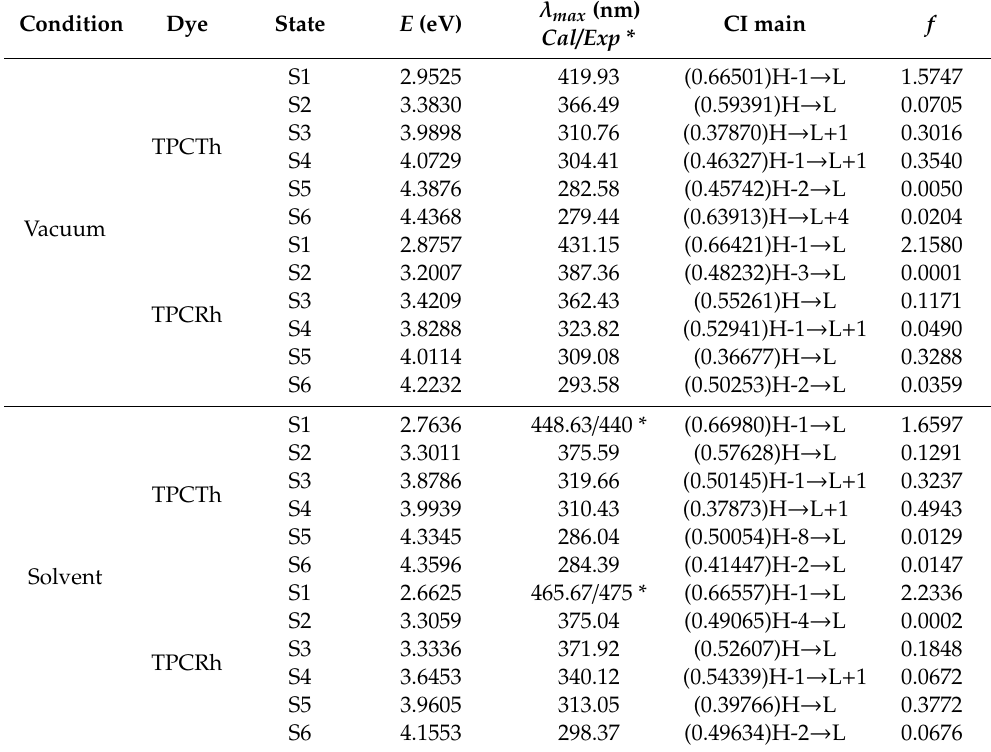
Table 3. Transition energies (eV), absorption peaks (nm) and oscillator strengths of TPCTh and TPCRh in vacuum and